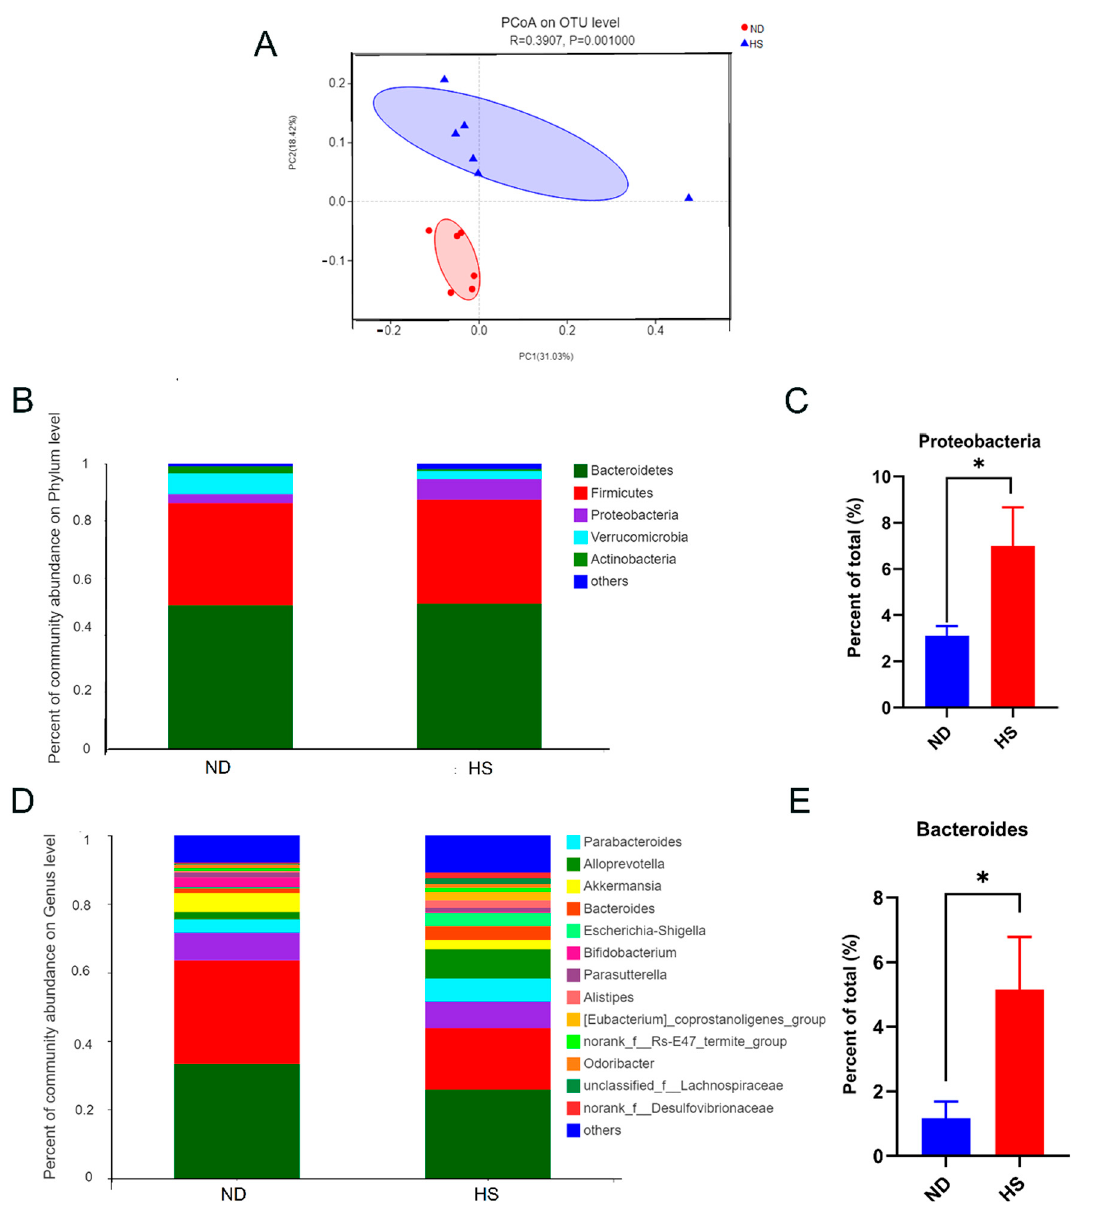
Figure 3. Effect of perinatal high-salt (HS) diet on gut microbiota of weanling offspring. ( A ) Principal coordinates analysis (PCoA) of unweighted Unifrac distances on the operational taxonomic unit (OTU) level. Each point represents one sample. Red dots represent normal diet (ND) samples, and blue triangles represent HS samples. Closer sample points indicate higher similarity in the species composition of the two samples. R-value represents inter-group differences and intra-group differences. A higher R-value indicates a greater difference between groups than the intragroup difference. ( B ) Relative abundance of bacterial phyla. ( C ) Relative abundances of Proteobacteria . ( D ) Relative abundance of bacterial genera. ( E ) Relative abundances of Bacteroides . * p < 0.05 was considered a significant diffidence between the two groups.